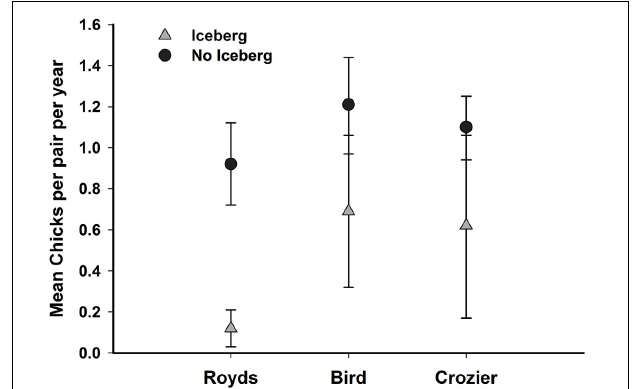
FIGURE 3 | The mean number of Adélie penguin chicks per pair (with 95% confidence limits) produced at Capes Crozier and Royds on Ross Island, Antarctica when icebergs were present (2001–2005) and when icebergs were not present (1997–2000,